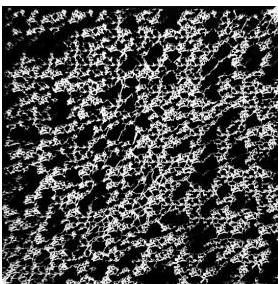
Figure 13. Glass-silicon-glass micromodel (40 × 40 × 0.05 mm) resembling the pore structure of Bentheimer sandstone [30].